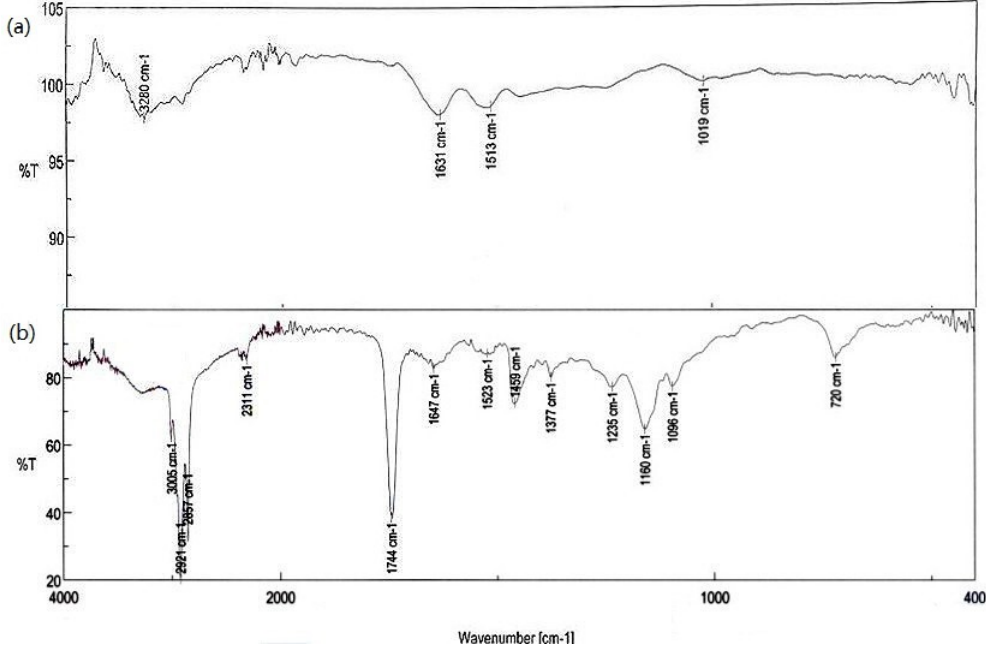
Figure 12. FTIR spectra of gelatin capsules without and with the gemini surfactants. ( a ) Ge@empty; ( b ) Ge@12(E)-O-12(E) Br.